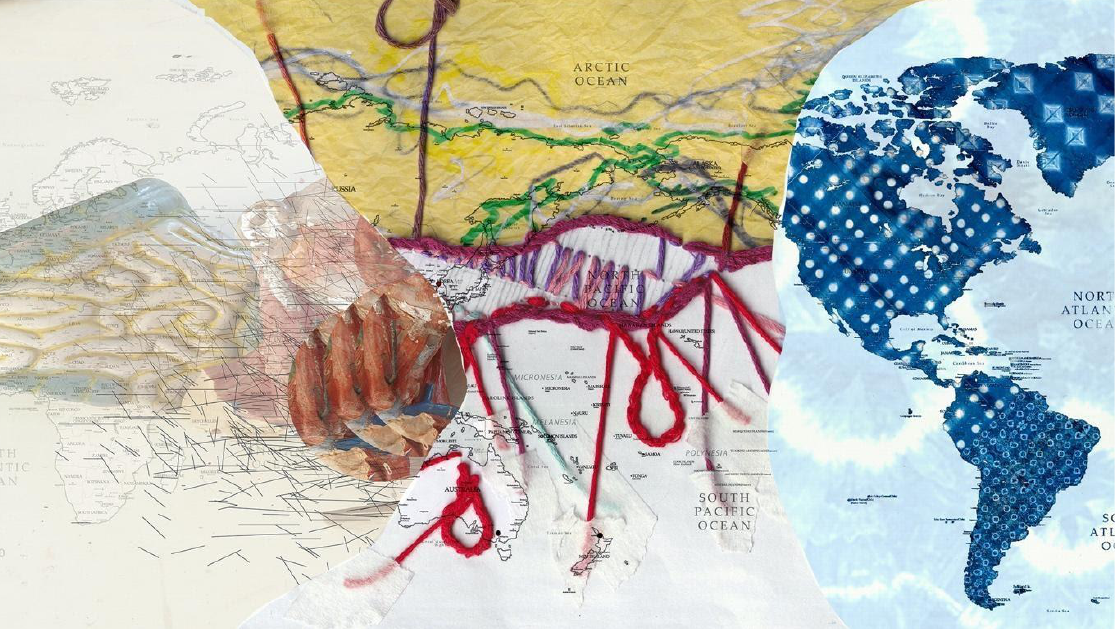
Figure 7: Artist Maps in the Let us Drink the New Wine Together!/ Beberemos El Vino Nuevo,